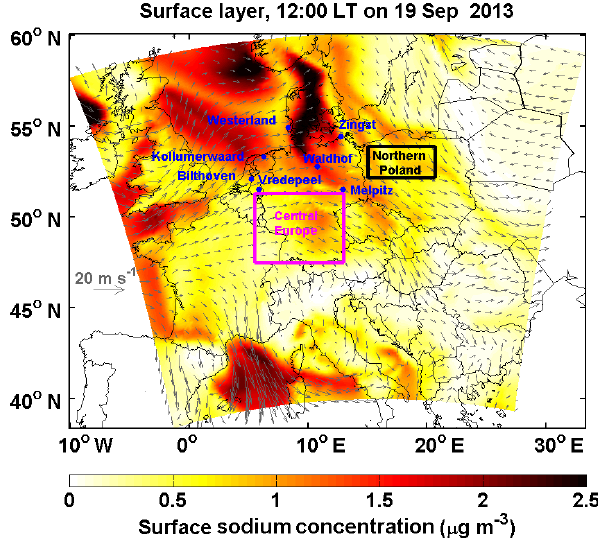
Figure 3. Surface sodium mass concentration over Europe do- main at 12:00 local time (LT) on 19 September 2013. The 10m wind is indicated by the gray arrows. The results are based on Case_SeasaltOn. Westerland, Waldhof, Zingst, Bilthoven, Kol- lumerwaard, Vredepeel, Melpitz, central Europe and northern Poland regions are